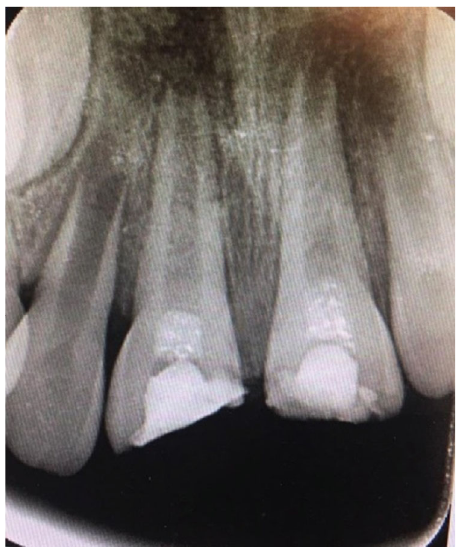
Figure 4: Follow-up after 4 weeks.